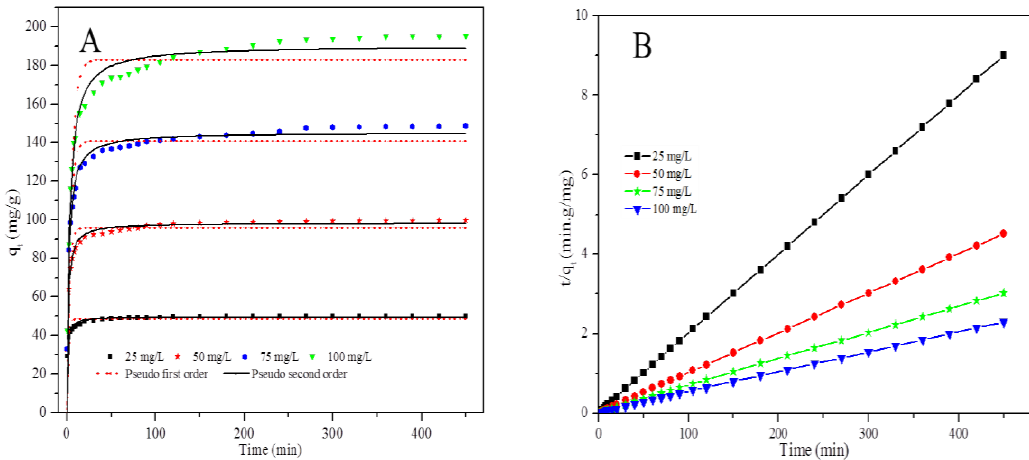
Figure 8. Nonlinear fitting of the data to the pseudo-first-order (PFO) and pseudo-second-order (PSO) kinetic models ( A ) and Fit of the data to the linear form of the PSO kinetic model ( B ) for Cr(VI) adsorption by the PPy– m PD/Fe 3 O 4 nanocomposite.